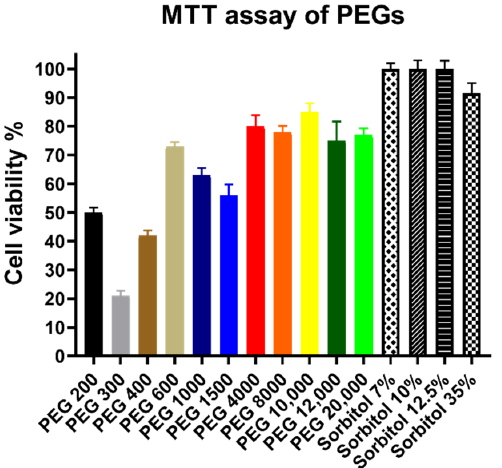
Figure 2. Cytotoxicity of PEG and sorbitol solutions measured by MTT assay on Caco-2 cells. Con- centrations of all PEG solutions were 30 w / v % and volumes were 100 μ L. Cell viability expressed as the percentage of the absorbance of the untreated control cells. Columns represent the mean, ± SEM, n = 10. Cell viability of the samples (mean ± SEM): PEG 200: 50% ± 2%; PEG 300: 21% ± 2%; PEG 400: 42% ± 2%; PEG 600: 73% ± 2%; PEG 1000: 63% ± 3%; PEG 1500: 56% ± 4%; PEG 4000: 80% ± 4%; PEG 8000: 78% ± 2%; PEG 10,000: 85% ± 3%; PEG 12,000: 75% ± 7%; PEG 20,000: 77% ± 2%;